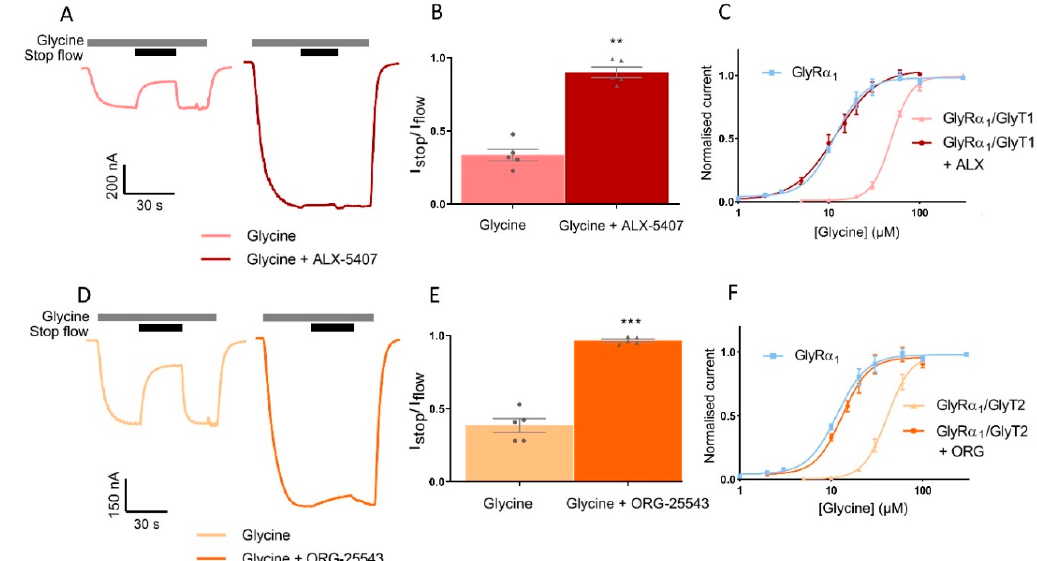
Figure 8. Pharmacological manipulation of stop-flow and fast-flow currents in GlyR α 1 / GlyT co-expressed cells. Example traces from cells co-expressing ( A ) GlyR α 1 / GlyT1 or ( D ) GlyR α 1 / GlyT2 showing co-application of glycine with GlyT1 inhibitor ALX-5407 or GlyT2 inhibitor ORG-25543, respectively (grey bars) prevents stop flow reduction (black bars) of glycine gated currents. Fast-flow currents are also larger when GlyT inhibitors are applied for both co-expressed cell types, suggesting GlyTs also reduce extracellularly available glycine under fast-flow conditions. I stop / I flow values were compared between application of 10 µ M glycine and 10 µ M glycine in the presence of a GlyT inhibitor in the same cell expressing ( B ) GlyR α 1 / GlyT1 or ( E ) GlyR α 1 / GlyT2. ALX5-407 and ORG-25543 reduce the EC 50 s for glycine for cells co-expressing GlyR α 1 and ( C ) GlyT1 and ( F ) GlyT2, respectively. Glycine dose-response curves for co-expressed cells in the presence of GlyT inhibitors are superimposed on dose-response curves for GlyR α 1 alone, suggesting the e ff ects of GlyTs in this system can be pharmacologically reversed. Currents are normalised to I max and fit to the Hill equation. Data are presented as mean ± SEM ( n ≥ 5). Values in the same cell were compared using a paired t -test. ** denotes p ≤ 0.01 and *** denotes p ≤ 0.001. Table 5. Changes in I stop / I flow and glycine EC 50 using GlyT inhibitors in GlyR α 1 / GlyT co-expressed cells.